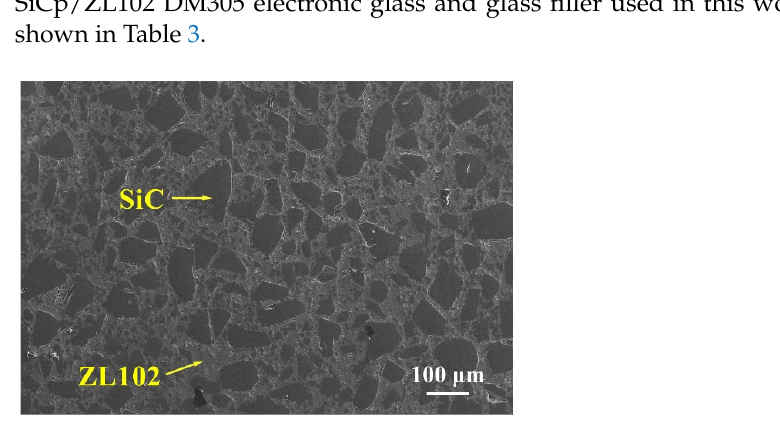
Figure 1. Microstructure of 65vol.% SiCp/ZL102 MMCs. Table 1. Chemical composition of ZL102 (in wt.%).